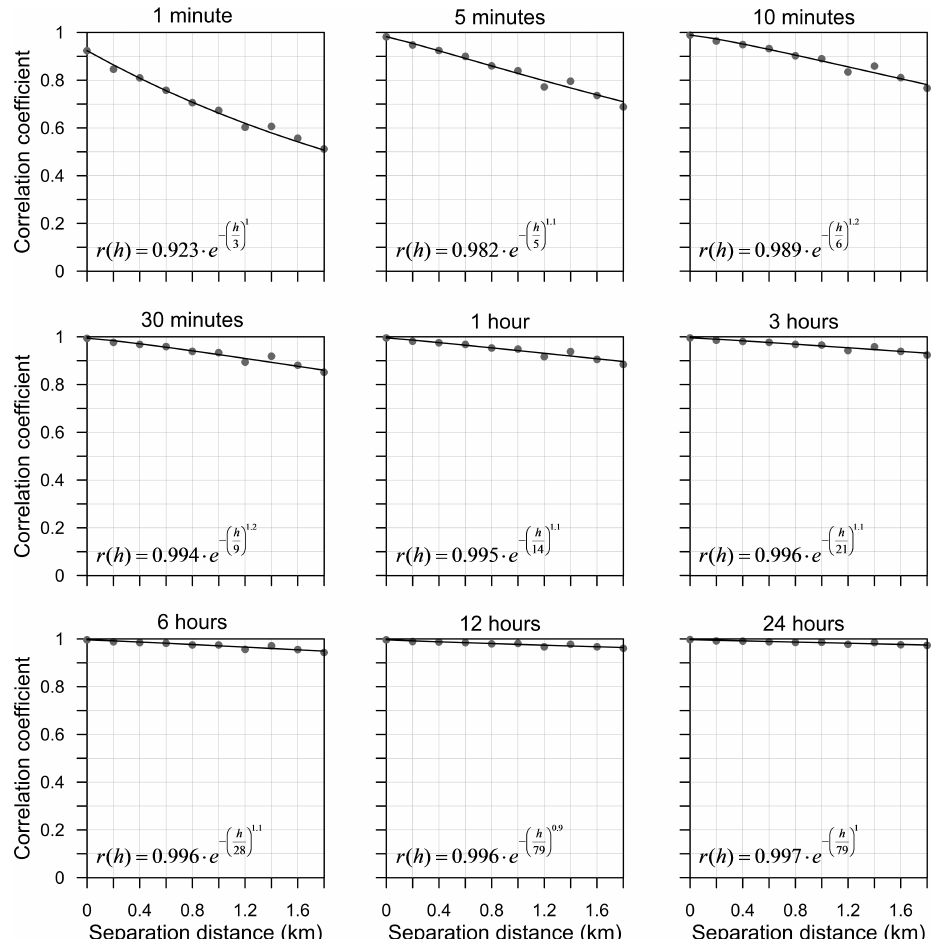
Fig. 3. Correlograms of the rainfall derived from the rain gauges for several timescales (dots) and the fitted three-parameter exponential functions